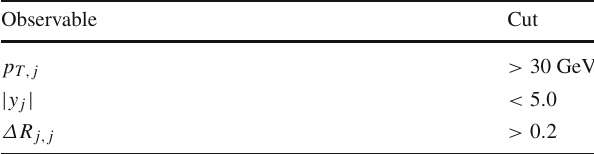
Table1 Thegeneration-levelcutsimposedontheprocesses.Theindex j indicates any quark flavour or gluons